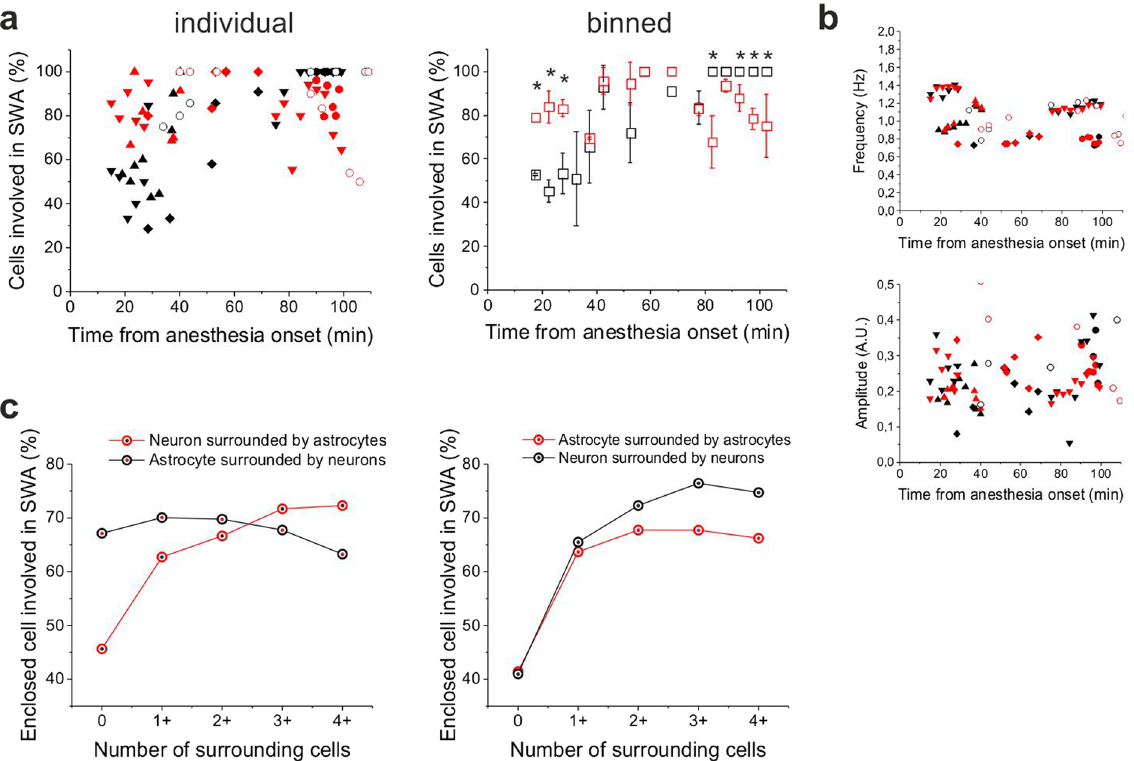
Figure 5. Extensive synchronized astrocytic activity contributes to the emergent neuronal synchronization in the early stage of ketamine/xylazine anesthesia. ( A ) The ratio of astrocytes (red) and neurons (black) showing repetitive, UP state-related Ca 2 + transients in percentage of all astrocytes or neurons, respectively, in the field of view from 5 different (P21-P83) animals ( left ) and their averages at 5-minute intervals (mean ± SD) ( right ). Asterisks show significant differences between astrocytes and neurons (p < 0.001). ( B ) Frequency and amplitude of detected UP state-related Ca 2 + transients. ( C ) Effect of the number of surrounding (d < 100 μ m) active cells on the ratio of astrocytes (red) and neurons (black) showing repetitive, UP state-related Ca 2 + transients in percentage of all astrocytes or neurons, respectively, having the same number (0) or same minimum number (1 + , 2 + , etc.) of adjacent cells. Percentage data are calculated from n = 5 (P21–P83) animals. Red markers represent astroglia, black markers represent neurons. Different symbols represent data from different animals. Astrocytes were identified by SR101 loading (solid symbols) or by astrocyte-specific expression of the red- fluorescence RGECO protein under the control of a GFAP promoter (empty symbols). Ketamin/xylazine was applied at t =